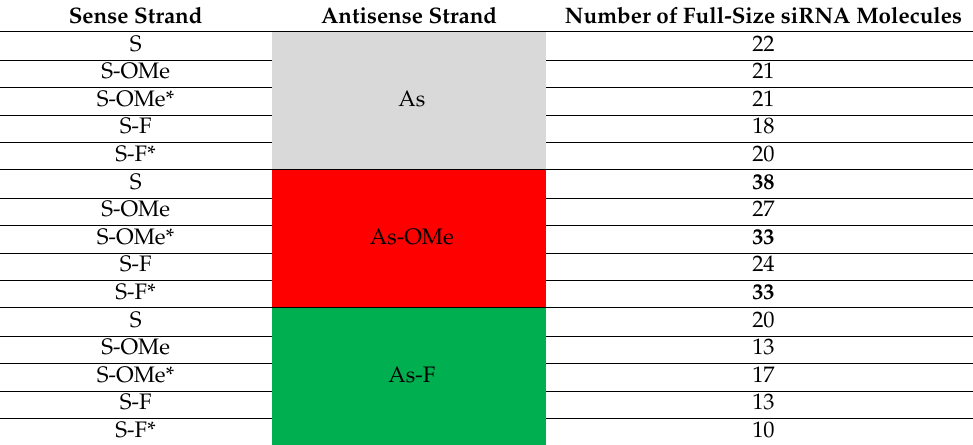
Table 3. Calculated numbers of released siRNA molecules in the cell from one MLNC containing one AuNP core. Sense Strand Antisense Strand